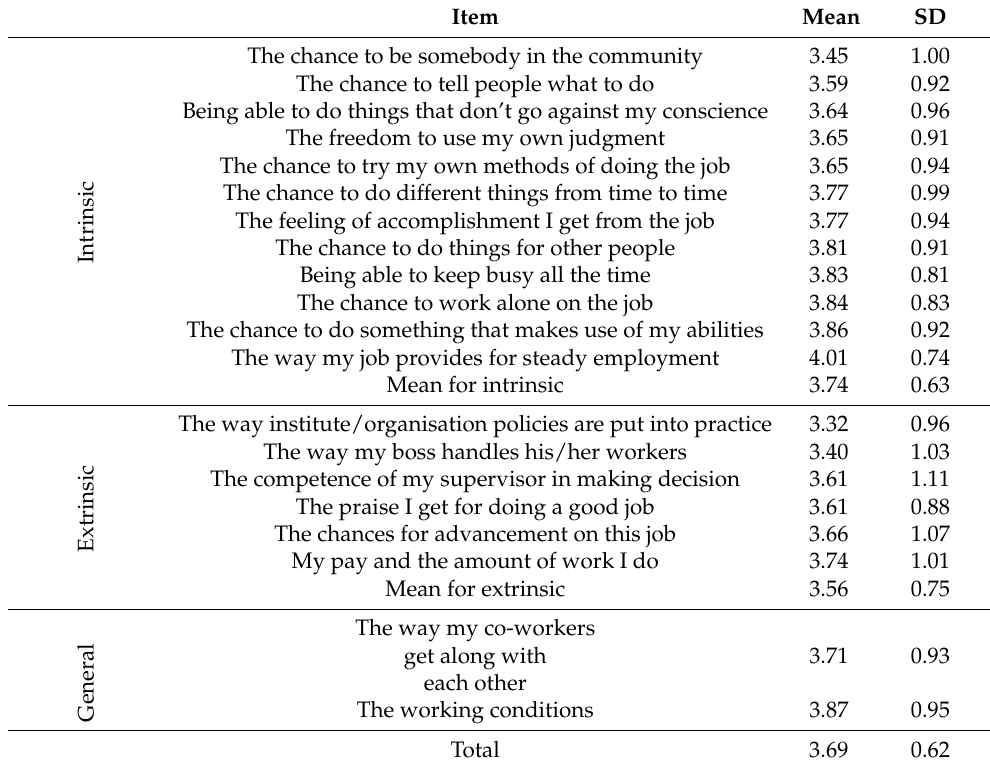
Table 2. Descriptive statistics related to job satisfaction ( n =